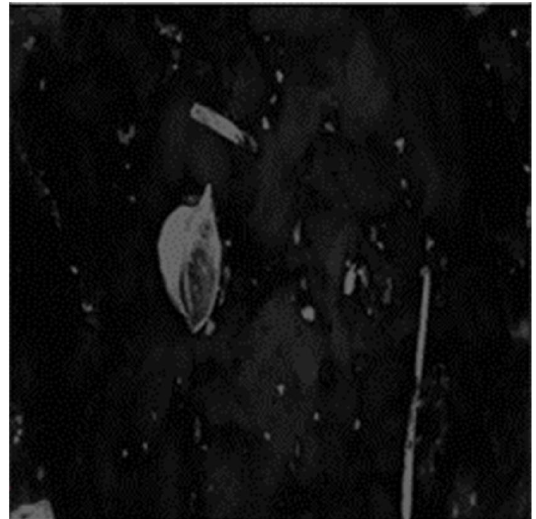
Figure 7. Mean filtering.